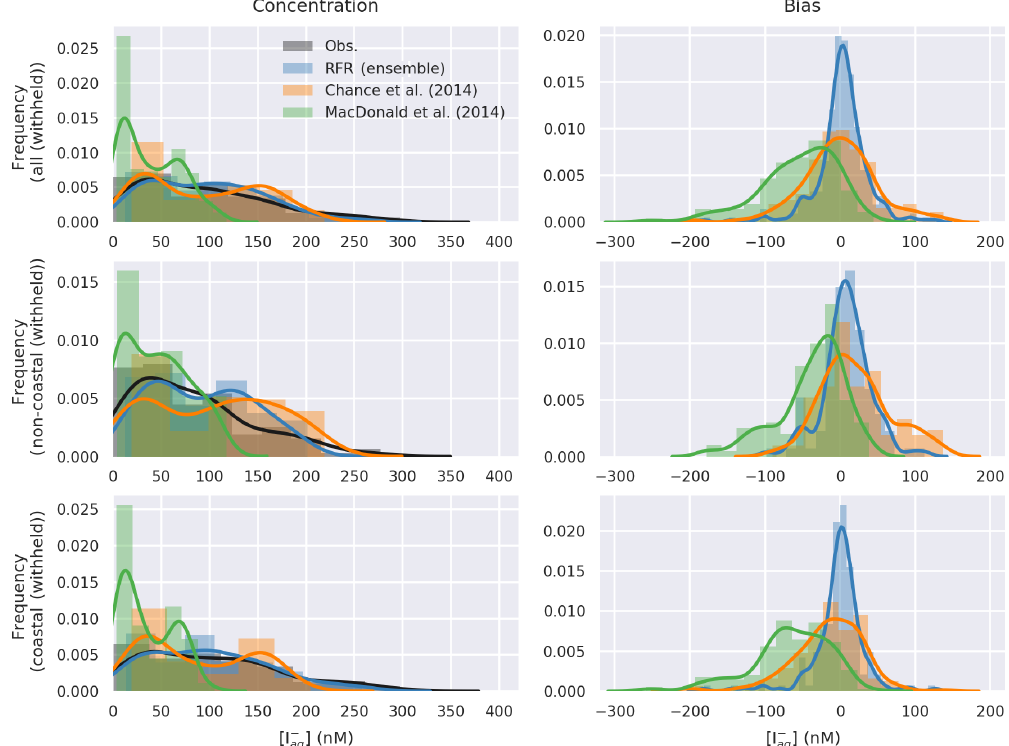
Figure 5. Probability density function (bars) and Gaussian kernel density (lines) estimate of observations and predicted concentrations (left), and bias (right, model minus observations) in entire withheld dataset (upper, N = 259), the withheld coastal dataset (middle, N = 157), and the withheld non-coastal dataset (lower, N = 102).